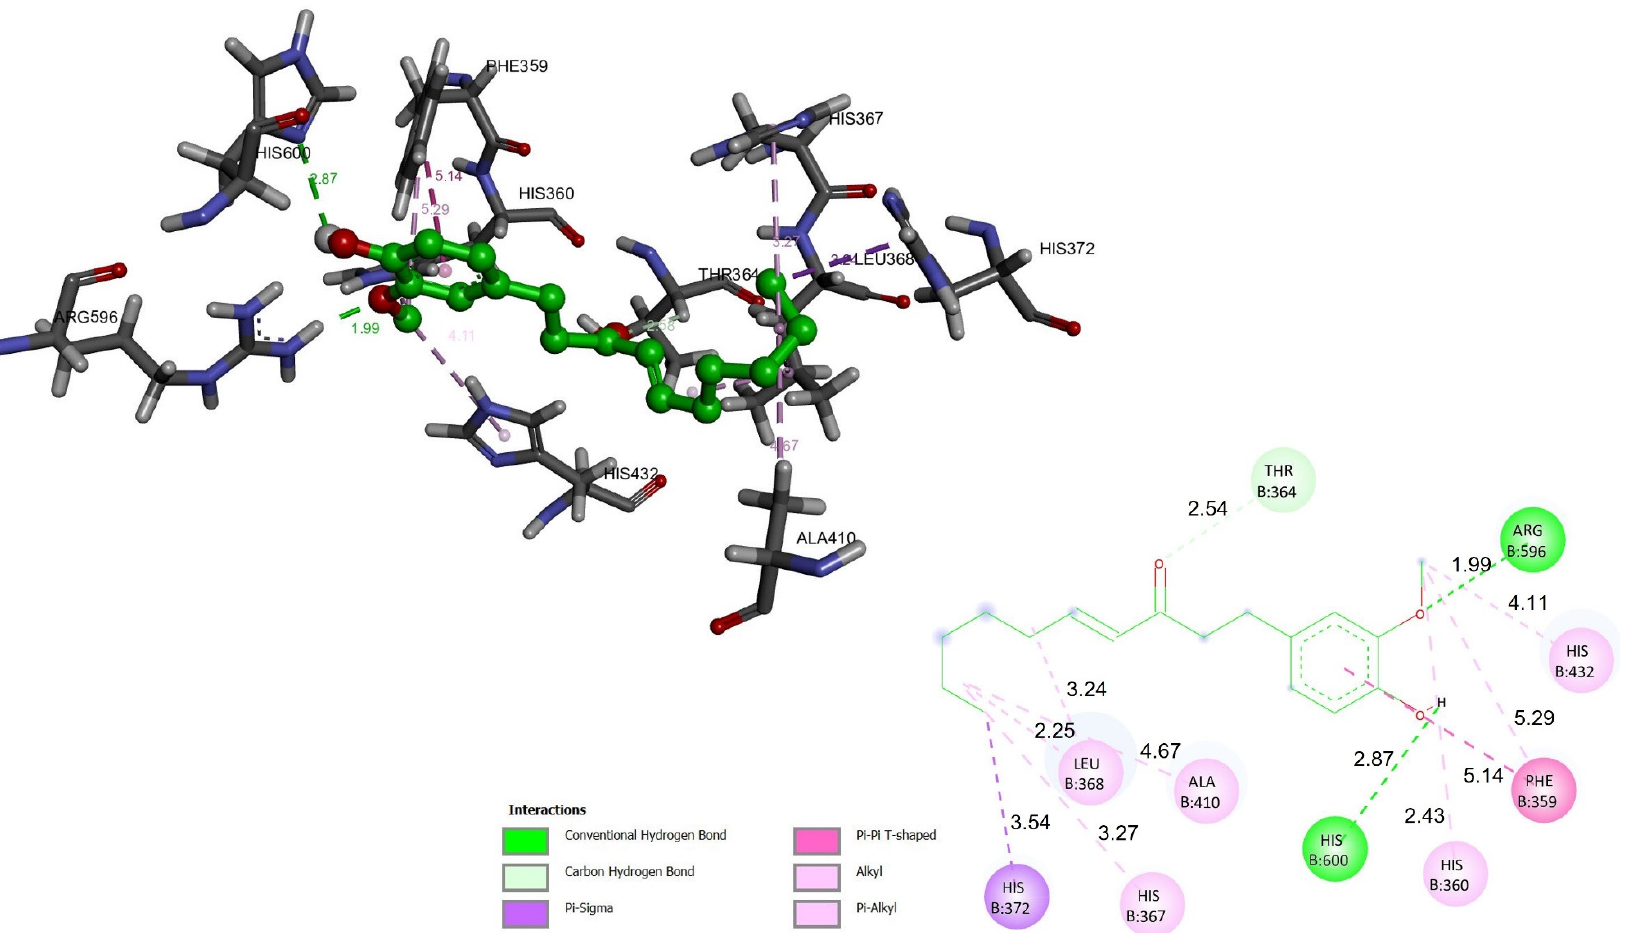
Figure 3. Molecular docking of 6-shogaol with 5-LOX (PDB:6N2W). The main residues involved in protein–ligand interactions ( left ) and the main interactions involved in protein–ligand binding ( right ) of 6-shogaol, distances are showed as Å over the lines.